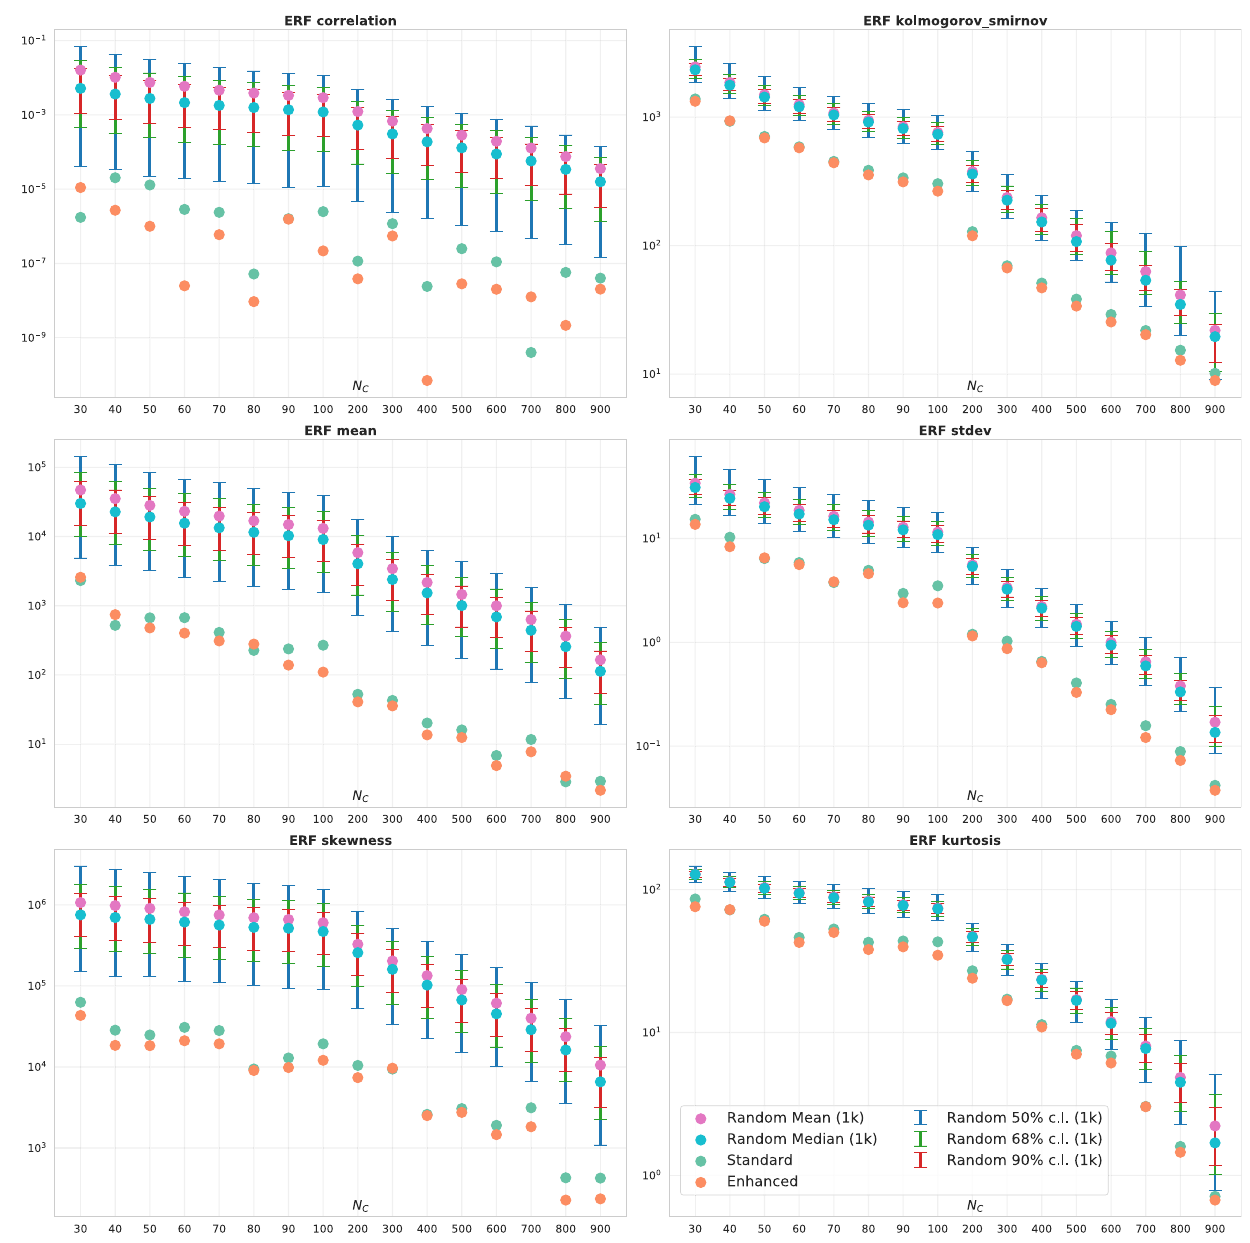
Fig. 10 Comparison of the best ERF values for the compression of a Monte Carlo PDF with N p = 1000 replicas. For each compressed set, we show the contribution of each of the statistical estimators that contribute to the total ERF using the standard compression (green) and the GAN-enhanced compression (orange) methodology. For illustra-